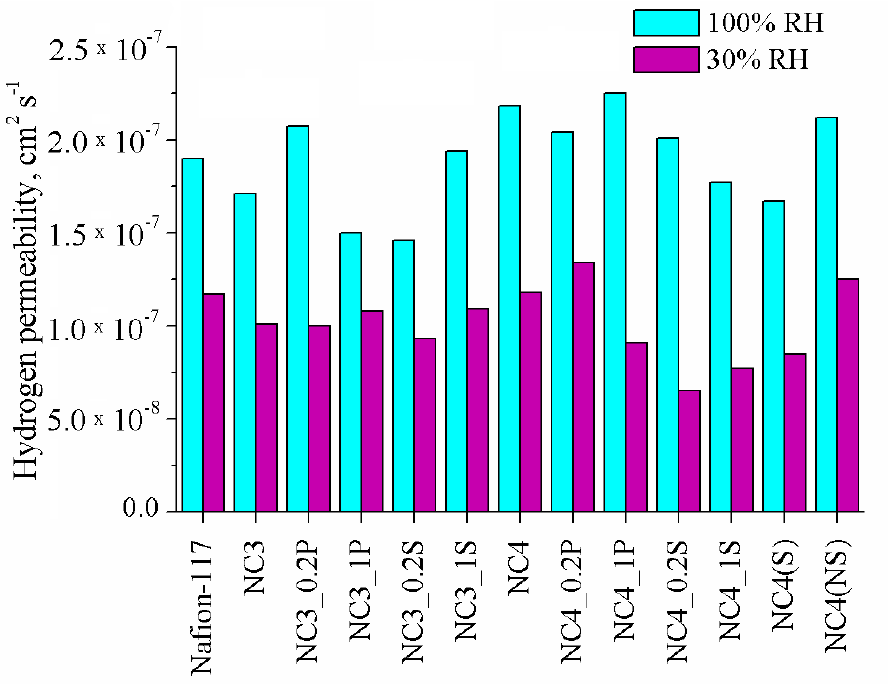
Figure 5. Hydrogen permeability at 30 and 100% RH of the studied composite